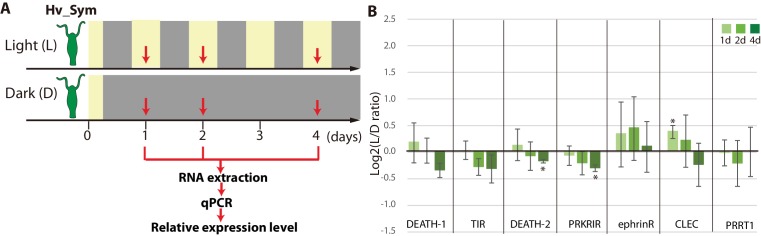
Differential expression of symbiosis-dependent Hydra genes grown under light/dark condition and in darkness.(A) Sampling scheme. Hv_Sym was cultured in the light-dark condition (Light: L) and in the continuous dark (Dark: D). Gene expression levels were examined by qPCR at 1, 2, 4 days for each condition (red arrows). (B) Expression difference of the genes in Hv_A99 between the two conditions. DEATH-1 and DEATH-2: Death domain containing proteins (gene ID: 6508 and rc_2417), TIR: Toll/interleukin-1 receptor domain containing protein (gene ID: 5168), PRKRIR: protein-kinase interferon-inducible double stranded RNA dependent inhibitor, repressor of (p58 repressor) (gene ID: rc_9398), ephrinR: ephrin receptor (gene ID: 26108), CLEC: C-type mannose receptor (gene ID: 11411), PRRT1: proline-rich transmembrane protein 1 (gene ID: rc_24563). For each biological replicate (n = 3) 50 hydra polyps were used for total RNA extraction. The vertical axis shows log scale (log2) fold change of relative expression levels in the light condition over the dark condition. Error bars indicate standard deviation. Pvalue of t-test, *<0.05, **<0.01.10.7554/eLife.35122.014Figure 2—figure supplement 1—source data 1.Hydra genes under influence of Chlorella photosynthesis examined by qPCR.